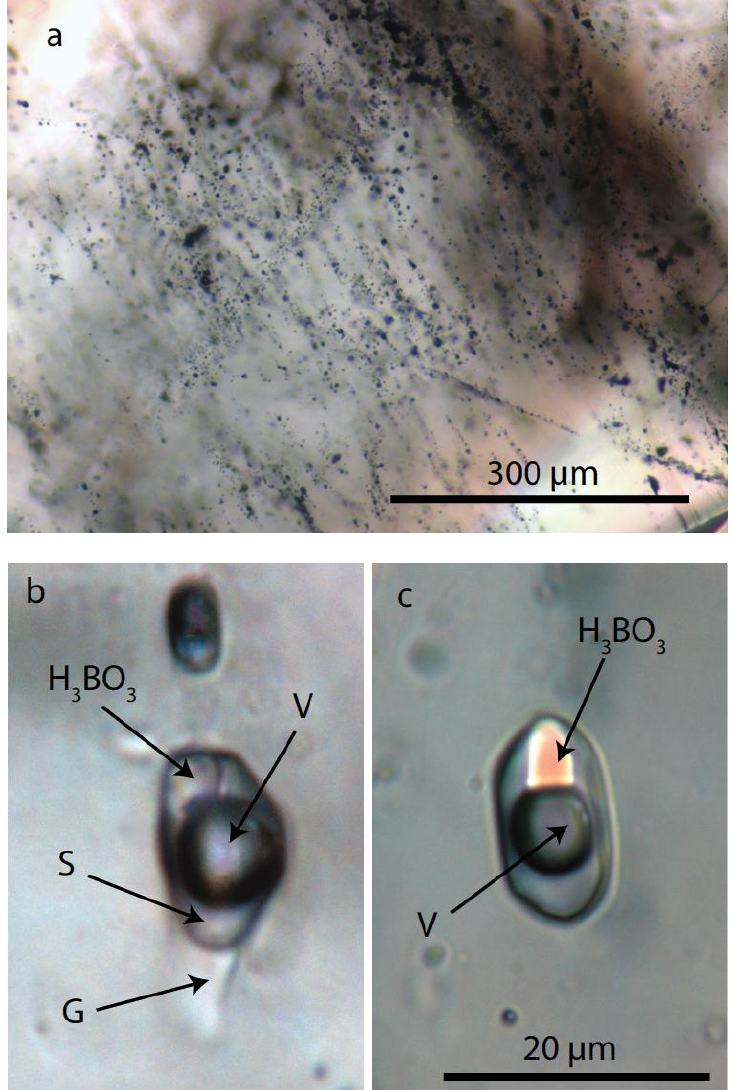
Figure 2. Microphotographs of fluid and melt inclusions in quartz of the granite from the Oreshnyi Massif. ( a ) shows a quartz grain with secondary inclusions in sub-parallel planes. Single inclusions in these planes after the homogenization run at 720 °C and 2 kbar are shown in ( b ) and ( c ). ( b ) is a melt inclusion also containing a sassolite daughter crystal; ( c ) is a fluid inclusion also containing a sassolite daughter crystal. S—water-rich solution, V—vapor,